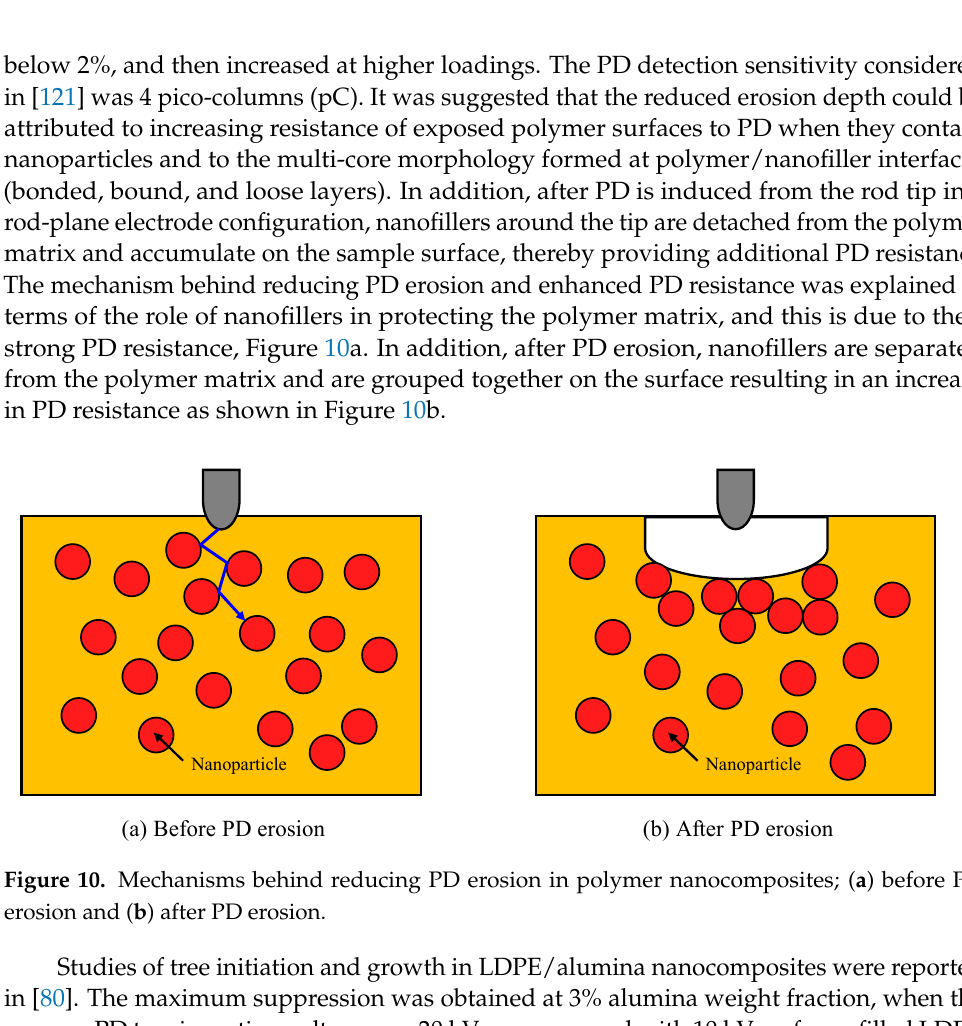
Figure 9. Electrode setup used for investigating PDs in polymer nanocomposites; ( a ) PD erosion test and ( b ) tree growth.